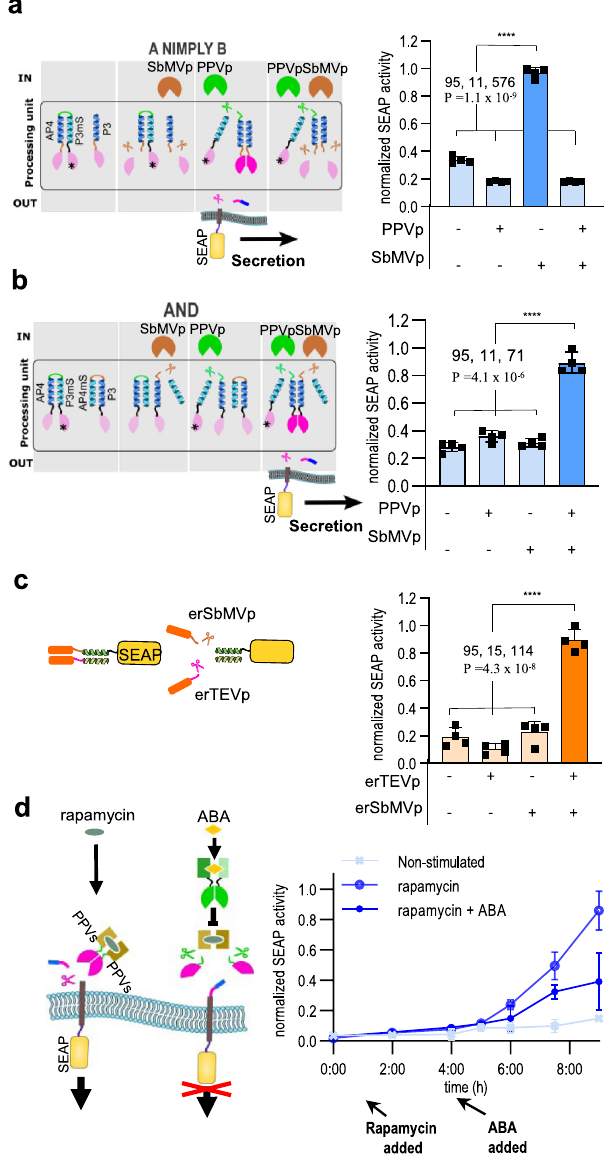
Fig. 5 Modular combinations and two-input signal-processing capacity of protein secretion systems. a A two-input Boolean logic processing